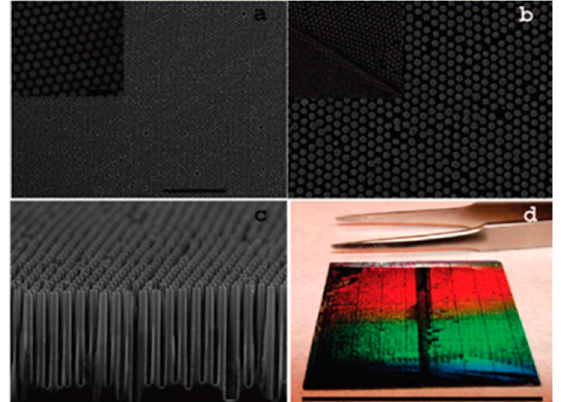
Figure 10 . ( a ) Monolayer of silica beads on a silicon wafer. Scale bar: 10 µm, inset: 1 µm SEM images: ( b ) Top view and ( c ) side view of silicon nanopillars after reactive ion etching. Scale bars are 1 µm ( d ) Tilted photograph of silicon nanowire radial p-n junction solar cell arrays [75]. Scale bar is 4 cm. Adapted with permission from Nano Lett. , 10 , 1082–1087. Copyright (2010) American Chemical Society.